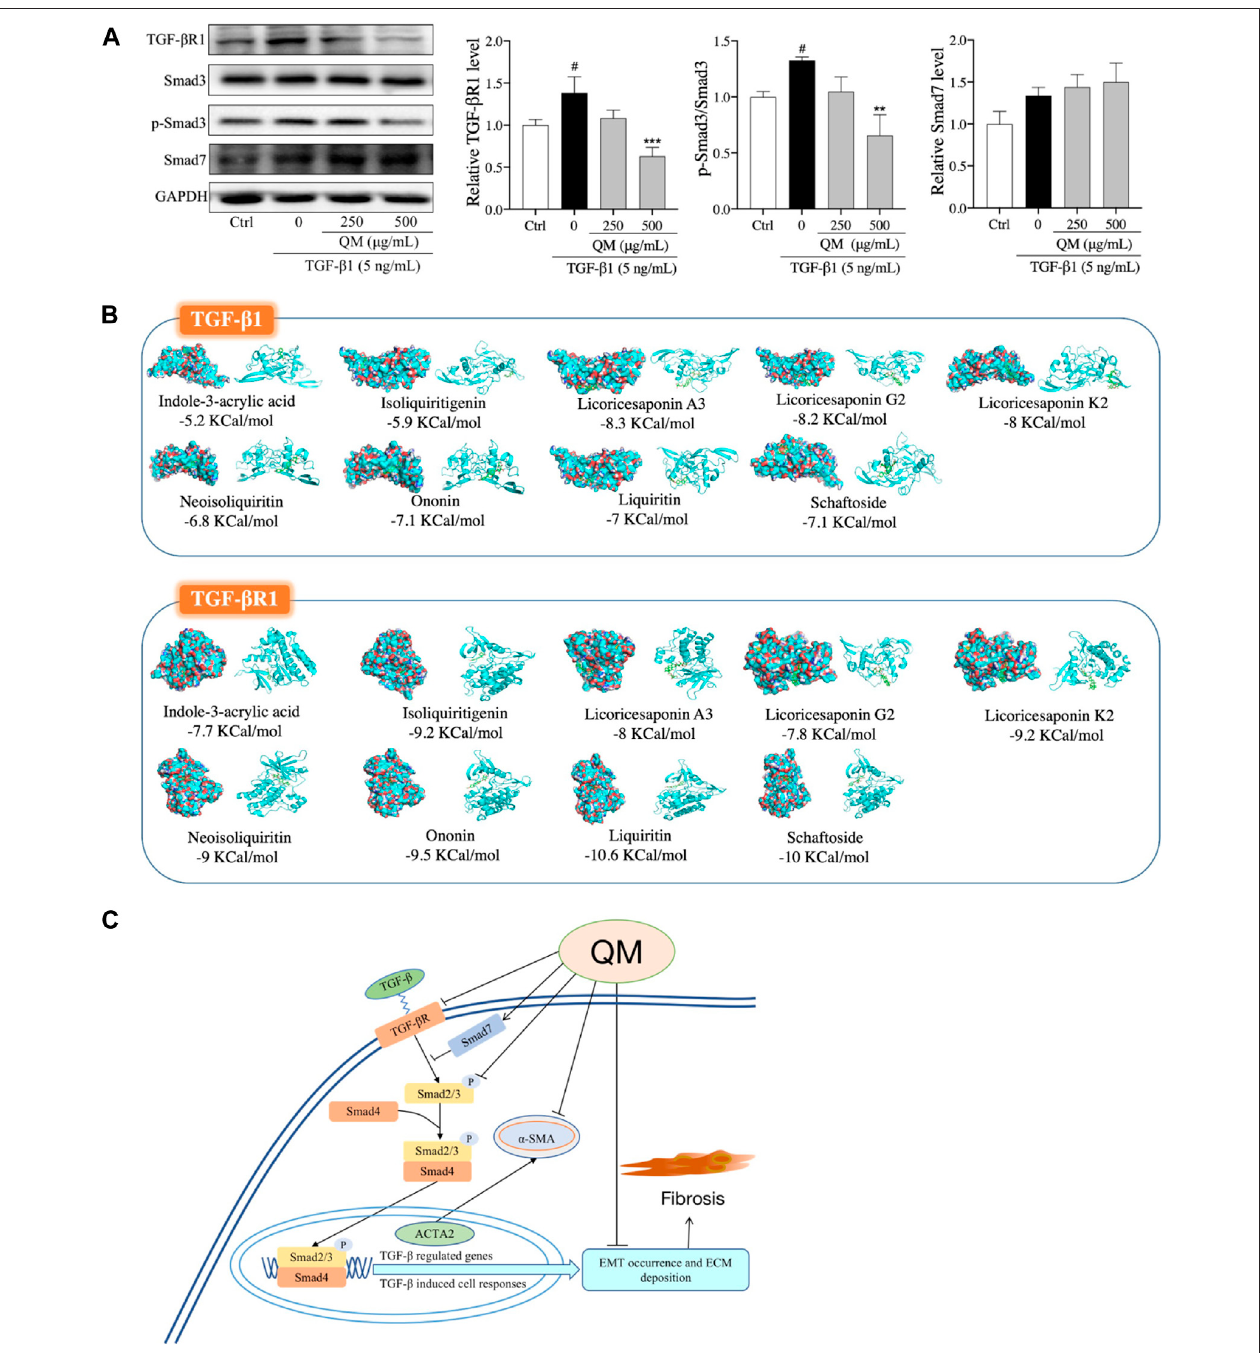
FIGURE 7 | QM inhibited the TGF- β 1/Smad3 pathway to block PF progression. (A) After incubation with QM and TGF- β 1 for 72 h, the protein levels of TGF- β R1, Smad3, p -Smad3 (S423/S425), and Smad7 in A549 cells were determined by Western blot analysis. GAPDH was used as the loading control. The ratio of p -Smad3/ Smad3 was calculated from three independent experiments after normalization to GAPDH. # p < 0.05 versus the control group; ** p < 0.01 and *** p < 0.001 versus the model group (TGF- β 1 5 ng/ml). (B) The molecular docking simulation results, including the compounds, the targets, and the lowest binding free energy. Green rectangles represent the compounds. The diagrams on the left are the surface appearances and those on the right are cartoon appearances of targets. (C) Scheme demonstrating the molecular mechanism underlying the effects of QM in preventing and treating PF.